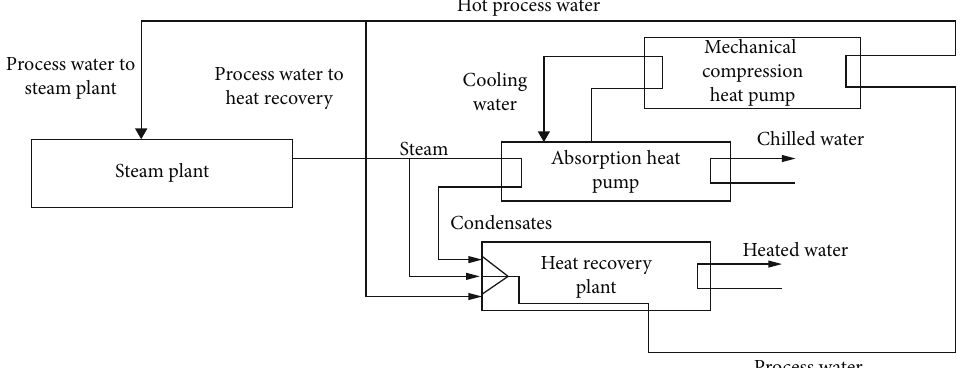
Figure 11: Trigeneration system [153].